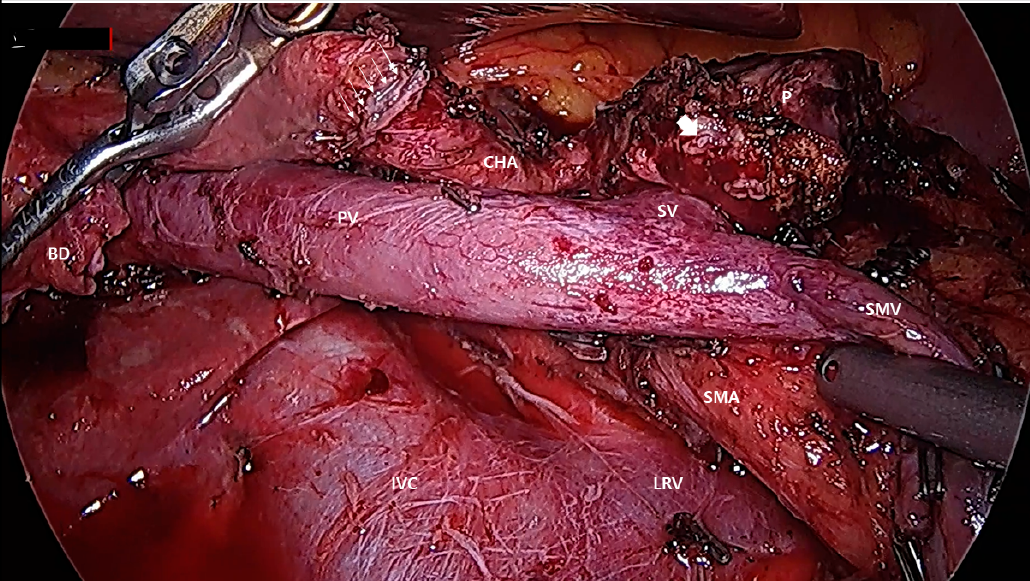
Figure 1. Laparoscopic view after resection of pancreatic head cancer . BD; bile duct, PV; portal vein, CHA; common hepatic artery. P; pancreas, SV; splenic vein, SMV; superior mesenteric vein, SMA; superior mesenteric artery, LRV; left renal vein, IVC; inferior vena cava, gastroduodenal artery stump (white arrows), pancreatic duct (thick white arrow).